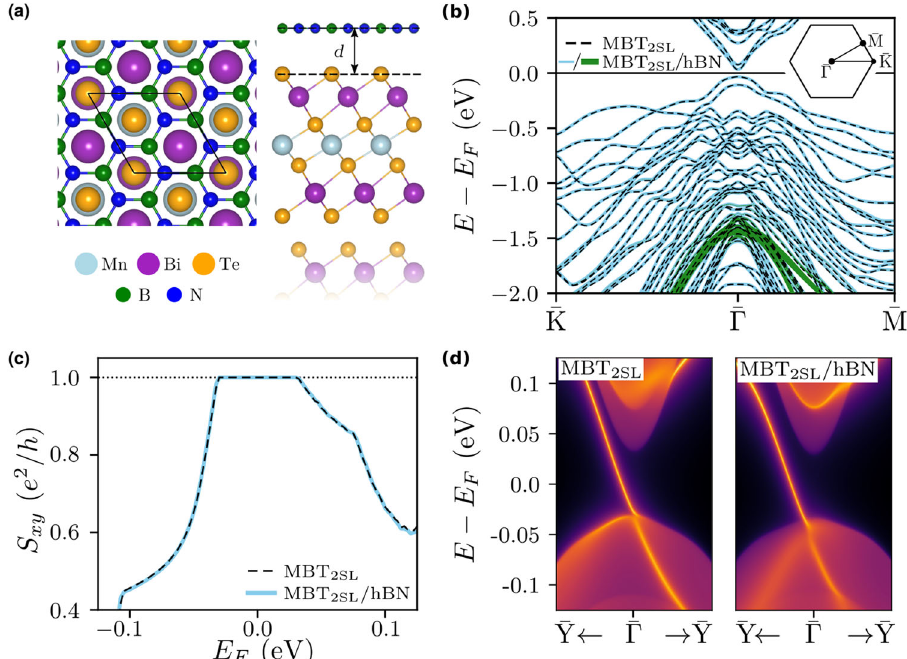
Fig. 2 Structural and electronic properties of MBT 2SL /hBN. a Top and side views of the hollow site MBT/hBN adsorption registry. b The band structures of MBT 2SL and MBT 2SL /hBN with hBN contribution are shown in green. c Fermi energy dependence of the anomalous Hall conductance S xy ( E F ) in the units of conductance quantum e 2 / h for MBT 2SL and MBT 2SL /hBN. E F = 0 corresponds to the center of the band gap. d The edge electronic band structures for MBT 2SL (left) and MBT 2SL /hBN (right). The regions with a continuous spectrum correspond to the 2D bulk states projected onto the 1D Brillouin zone. The edge crystal structure is shown in Supplementary Fig. 7. The data in ( b – d ) were calculated for the FM interlayer alignment in MBT 2SL (see